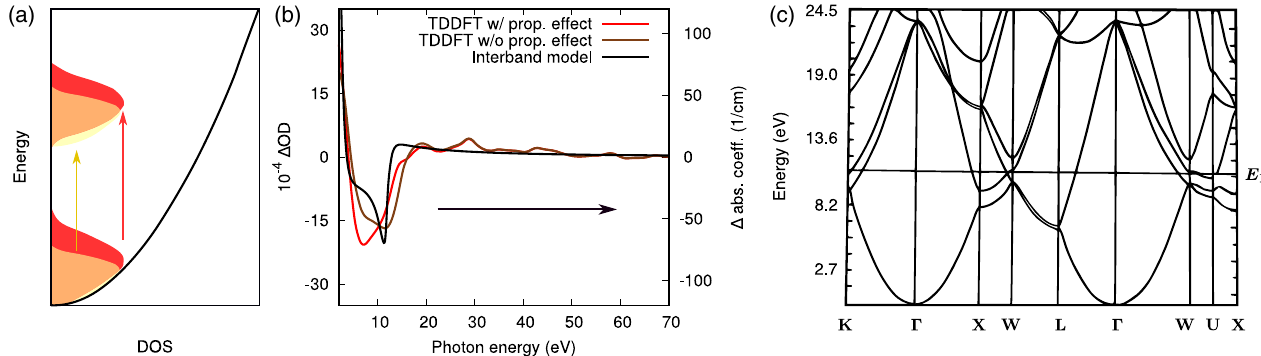
FIG. 3. (a) Schematic representation of the global increase in free-free absorption. Yellow stands for the nonexcited quasifree electron gas, and red for the excited electron gas. The vertical arrows correspond to the probe transition of the nonexcited or excited electron gas, while the pump is responsible for the broadening or heating of the electron distribution. Excitation by the NIR pump shifts the initial XUV states to higher energies. Thus, via the XUV probe transitions, final states will also be occupied at higher energies by pump- excited electrons compared to nonexcited electrons. Since the transition probability is given by the product of filled initial and empty XUV final states (Appendix L), there is a net increase in absorption for high photon energies because the DOS of a free-electron gas scales as the square root with energy. In panel (b), the brown (red) line shows the change in optical density predicted by the TDDFT calculations without (with) the propagation effect and surface reflection of the electromagnetic field included. The black line corresponds to a simple interband model, which includes the chemical potential shift. It leads to a decrease of absorption around the Fermi level and is in good qualitative agreement with the TDDFT calculations without propagation effects included. The chemical potential change ( − 26 meV) was calculated for an initial temperature of 300 K and a final temperature of 7000 K. The interband model is described in more detail in Appendix L. Panel (c) shows the band structure of aluminum along the symmetry